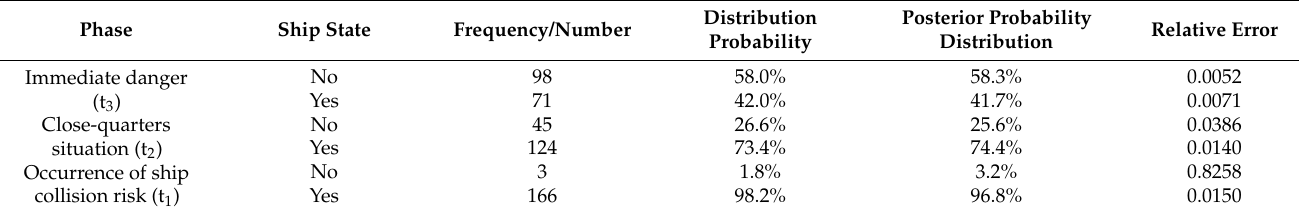
Table 6. Model validity analysis of the ship status node in the three phases.